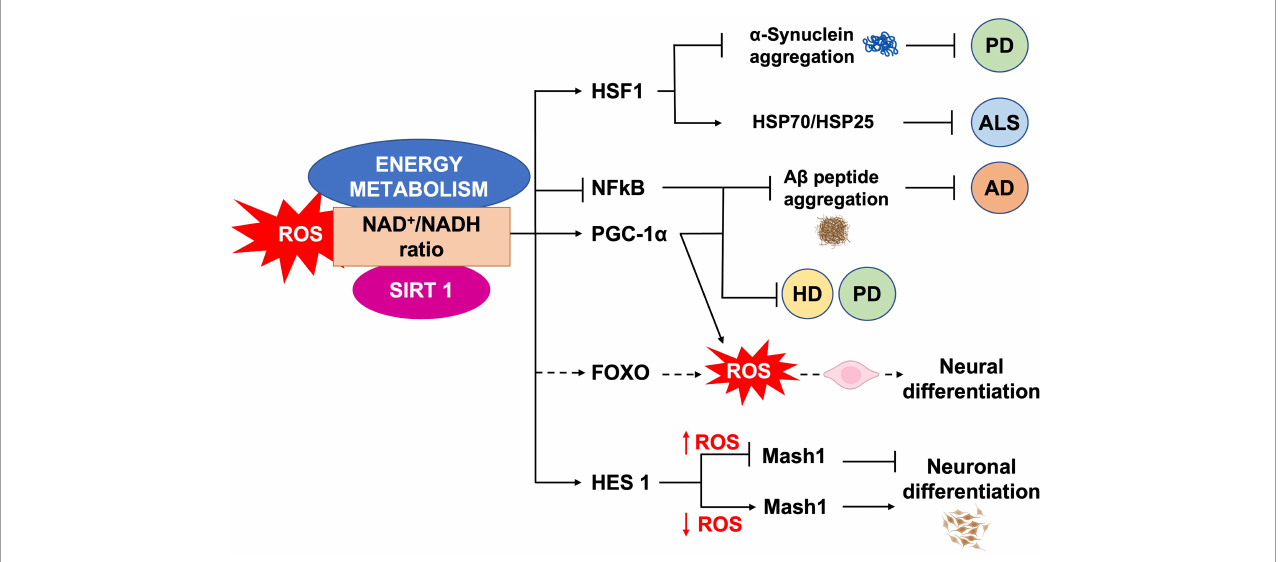
FIGURE5 ROS, SIRT1 and energy metabolism interplay. NAD + /NADH ratio is a measure of the cellular redox status, and plays a role in NSCs fate regulation, through SIRT1 activity. SIRT1 regulates neural differentiation as well as cellular pathways related to NDs, by regulating the activity of different transcription factors.